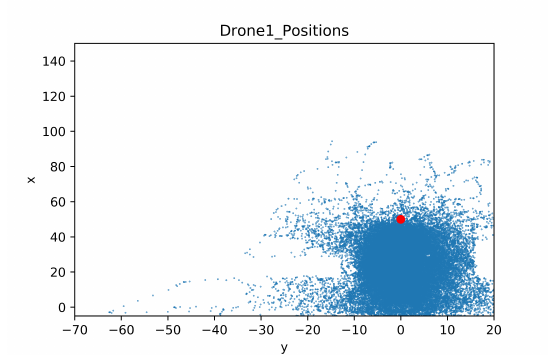
Figure 36. Drone Position Map for Case